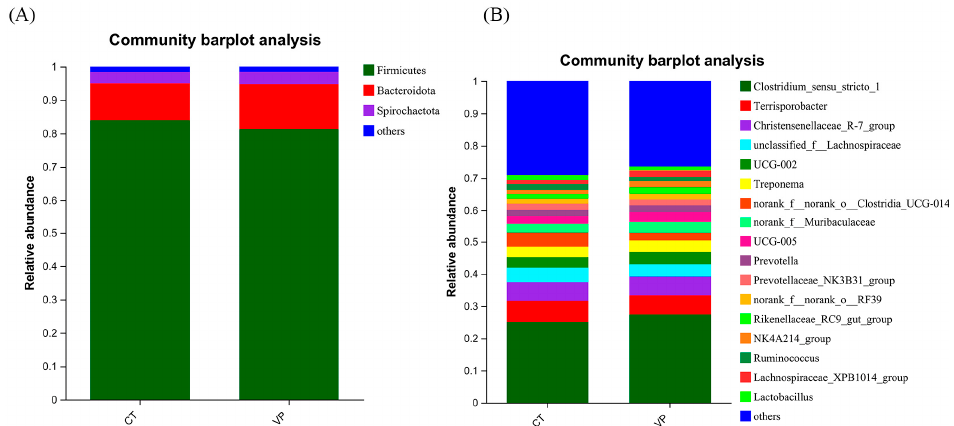
Figure 3. ( A ) The relative abundance of faecal microbiota composition at the phylum level, the Y -axis represents the average relative abundance, the X -axis represents the different groups, and the columns with different colors represent different groups. ( B ) The relative abundance of fecal microbial genus, the Y -axis represents the average relative abundance, the X -axis represents the different groups, and the columns with different colors represent different groups.